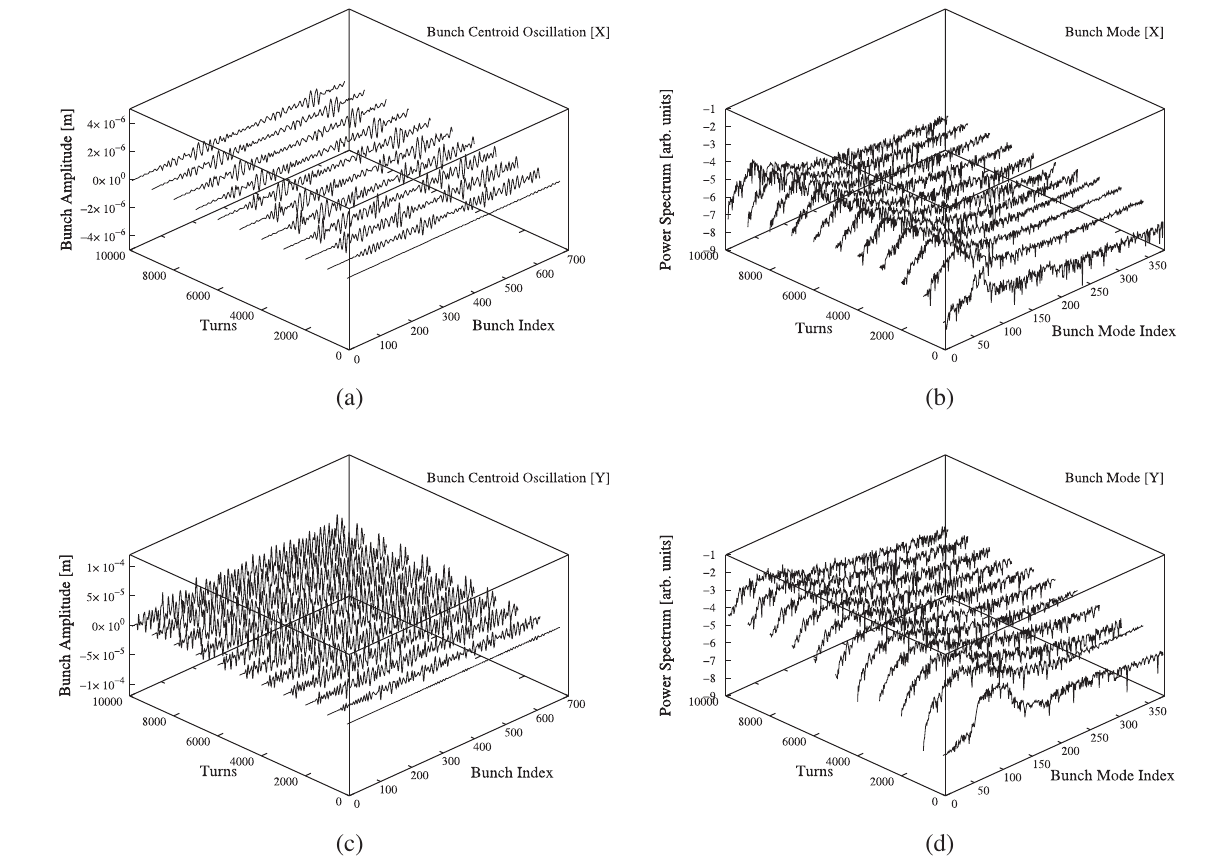
FIG. 3. Beam bunch oscillations in the horizontal (top) and vertical (bottom) and their power spectrum as a function of the passing turns. The coupled “ leading-trailing ” motions can be identified clearly. The simulation results are given by the weak-strong model with synchrotron radiation damping and quantum excitation.